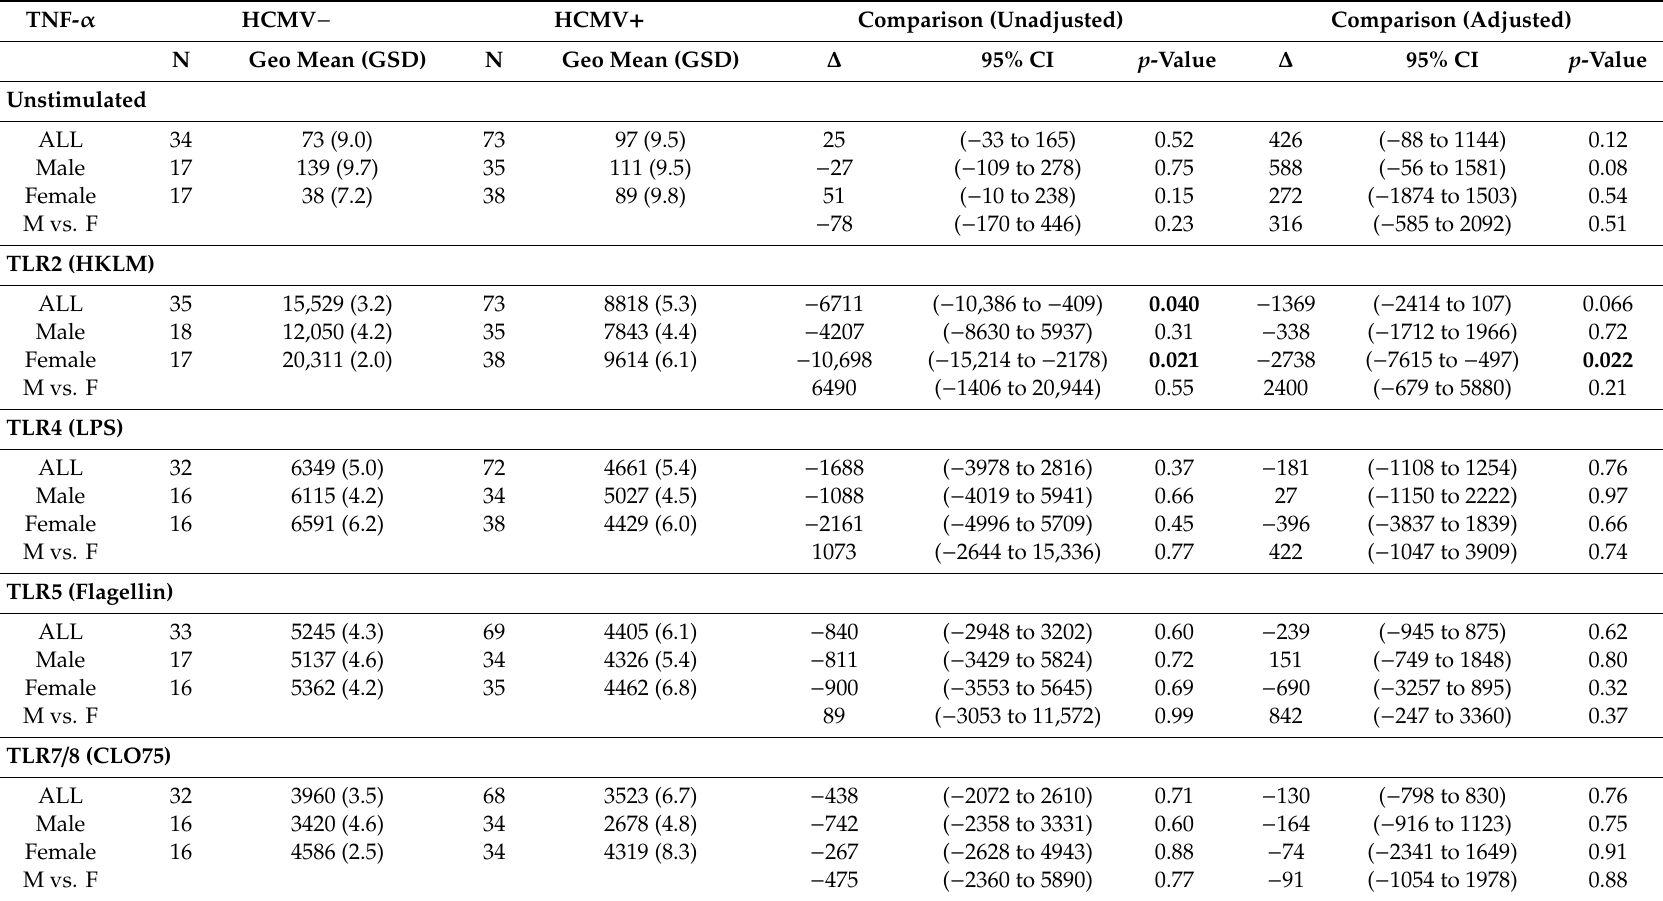
Table 2. E ff ect of HCMV infection on TLR ligand-stimulated TNF- α responses by infant